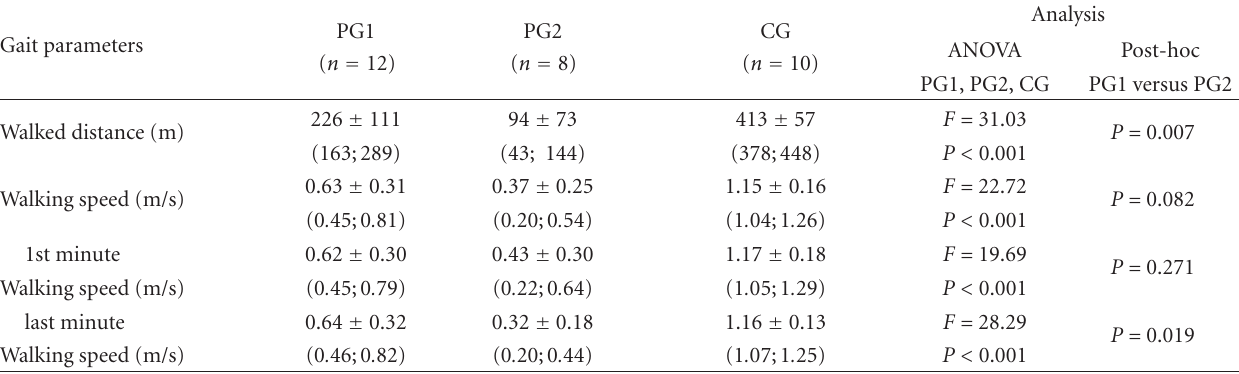
Table 2: Gait parameters. Mean ± standard deviation (CI 95% ) of gait parameters recorded during 6MWT for the three groups of participants. The last two columns reported the statistical analyses. For PG2, the last minute walking speed was the minute before